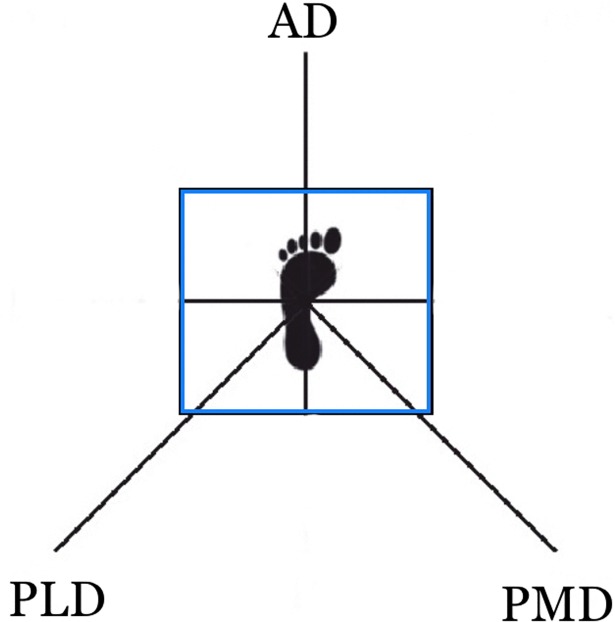
Star Excursion Balance Test for a left test leg.The box represents the force platform. The lines represent the three directions (Anterior, posteromedial, and posterolateral) used in the analysis.